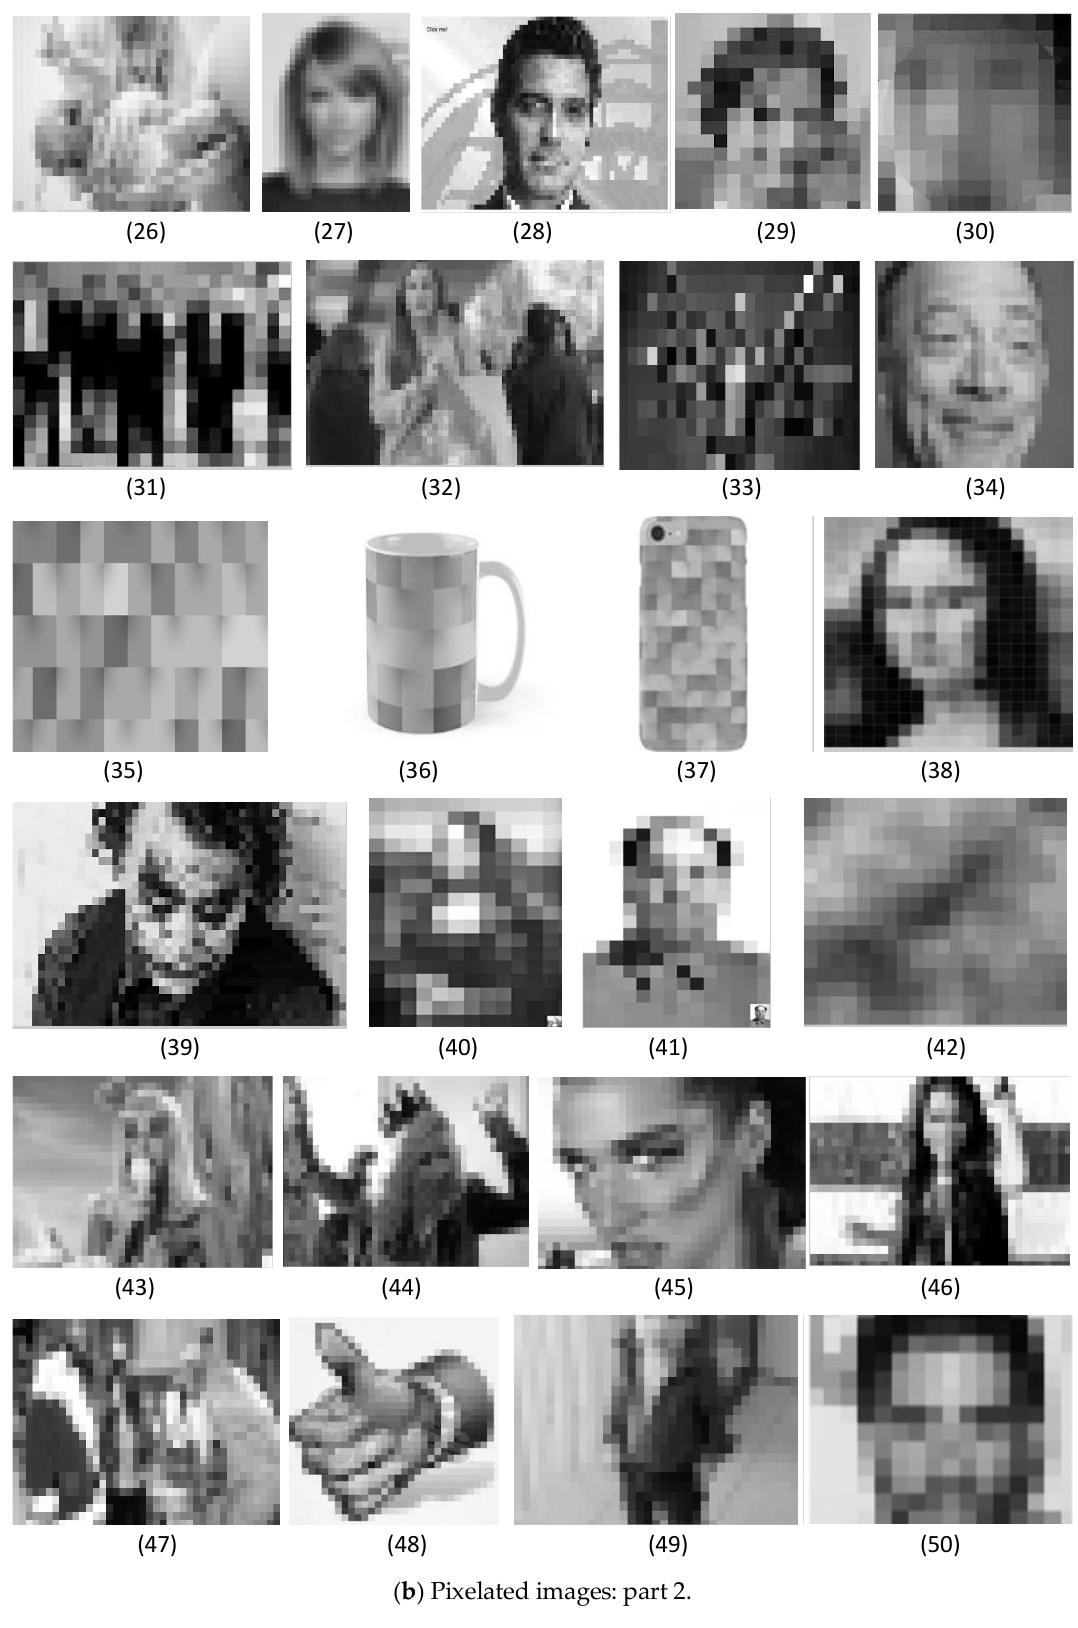
Figure 7. Tested pixelated images [46–49] .